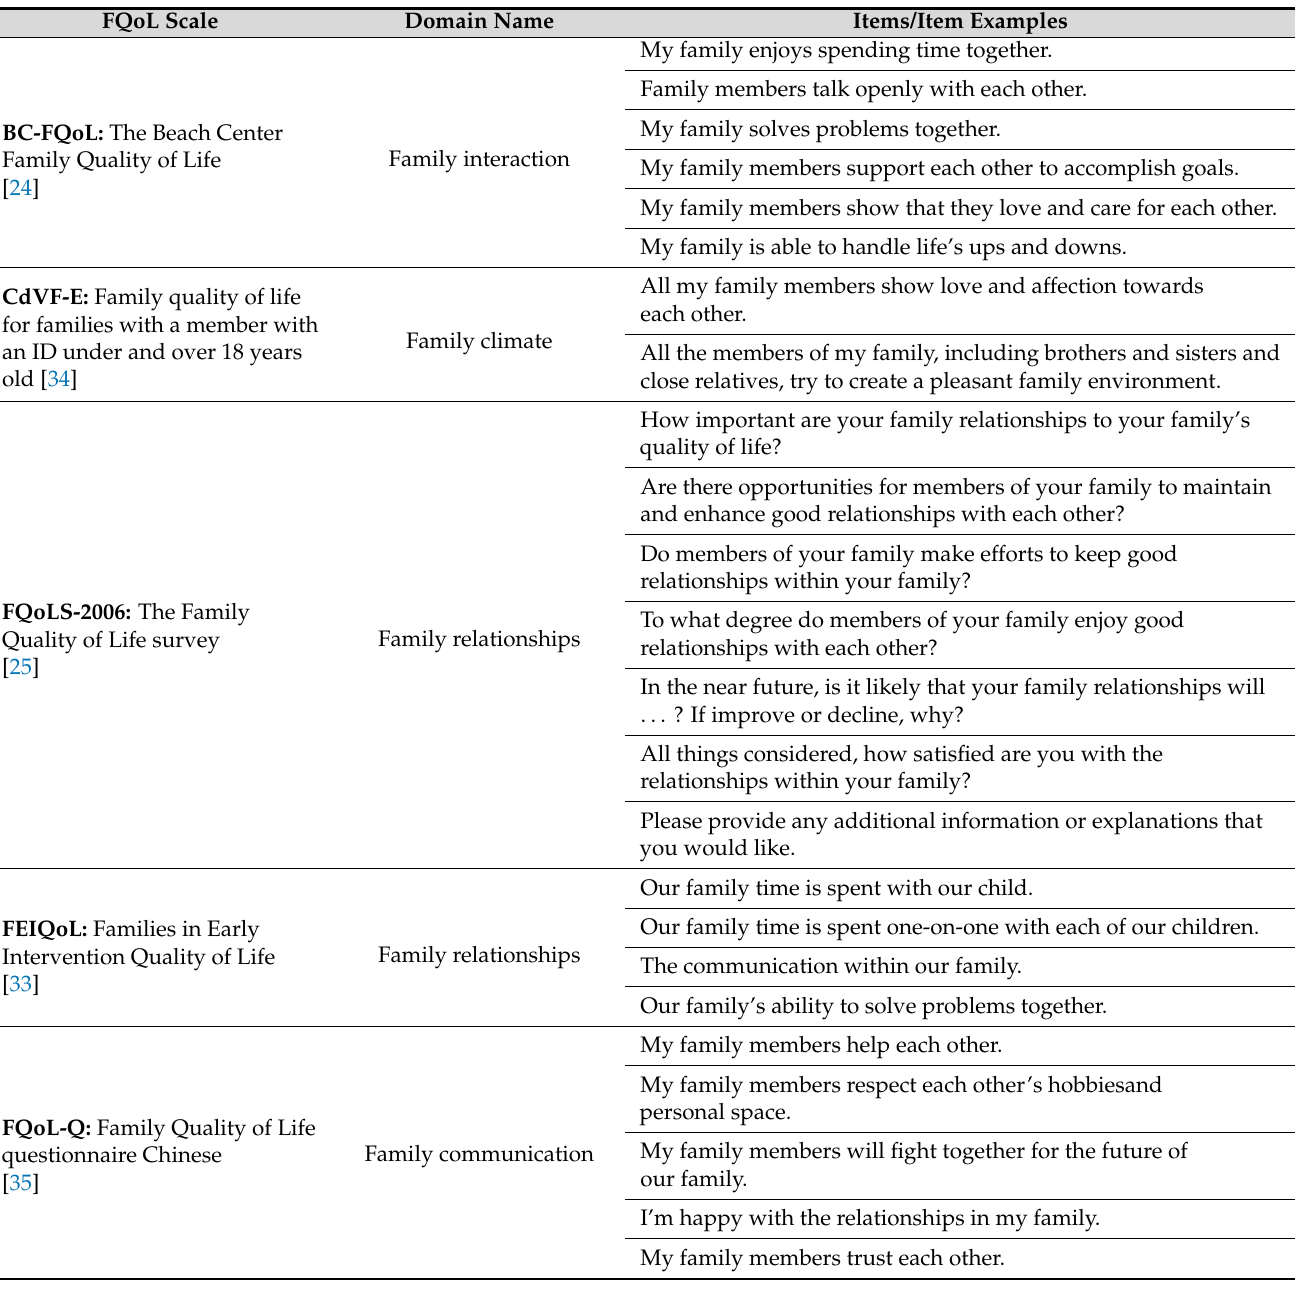
Table 2. Items/item examples considered in the domain of relationships/communication/family interactions within each FQoL